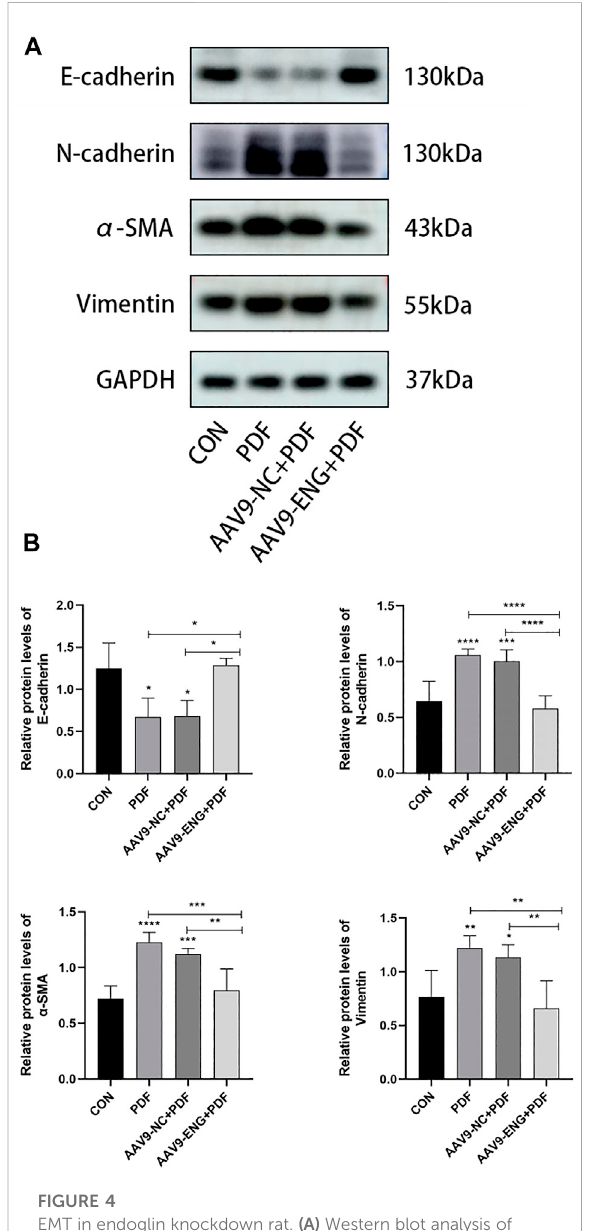
FIGURE 4 EMT in endoglin knockdown rat. (A) Western blot analysis of E-cadherin, N-cadherin, α -SMA and vimentin protein levels in different groups of rats. (B) The graphs showed the quantitative analysis of E-cadherin, N-cadherin, α -SMA and vimentin protein levels. n = 6. All quantitative data are expressed as mean ± SD, * p < 0.05, ** p < 0.01, *** p < 0.001, **** p <